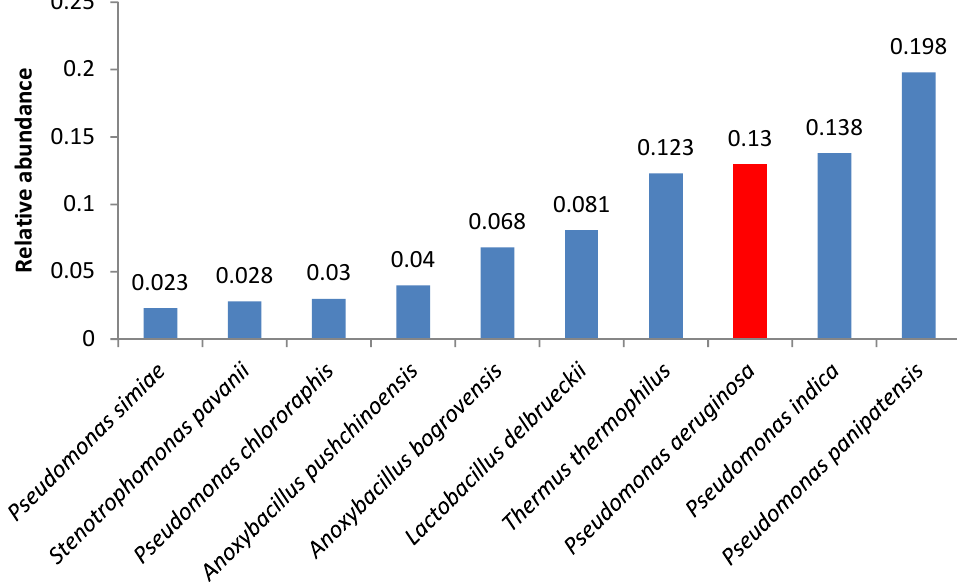
Figure 2. Relative abundance of amplicon sequence variants in butter sample no. 2.